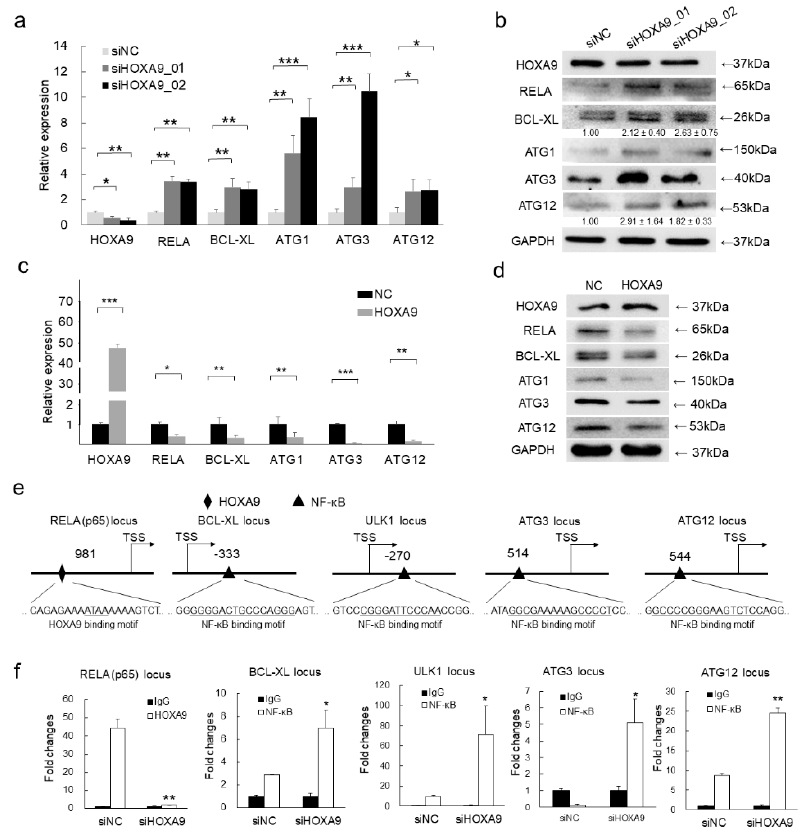
Figure 2. HOXA9 represses the expression of NF- κ B and its downstream apoptotic and autophagic genes by directly binding to the promoter region of NF- κ B. ( a – d ) The mRNA or protein expression levels of HOXA9, RELA (p65), BCL-XL, ULK1, ATG3, and ATG12 were detected by qRT-PCR ( n = 3) or western blot in cSCC cells after knockdown of HOXA9 by two siRNAs or overexpression of HOXA9. The qRT-PCR data were normalized to GAPDH gene expression. In western blots, GAPDH was used as a loading control. The bands of BCL-XL and ATG12 were densimetrically quantified ( n = 3). ( e ) Predicted binding site of HOXA9 (diamond) at the promoter of RELA (p65) or binding sites of RELA for on the promoter regions of BCL-XL , ULK1 , ATG3 , and ATG12 by rVista (https: // rvista.dcode.org / ). ( f ) The binding enrichment of HOXA9 at the RELA locus or RELA at the loci of BCL-XL , ULK1 , ATG3 , and ATG12 was detected by ChIP-qPCR after knockdown of HOXA9. One-Way ANOVA and Dunnett’s multiple comparison test. Means ± s.d., * p < 0.05, ** p < 0.01, *** p <